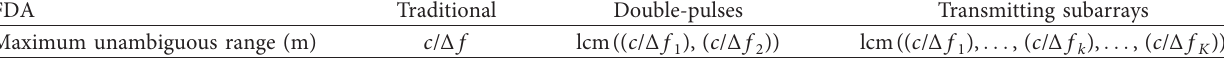
Table 1: Maximum unambiguous range of traditional, double-pulses, and transmitting subarrays monostatic FDA-MIMO radar. FDA